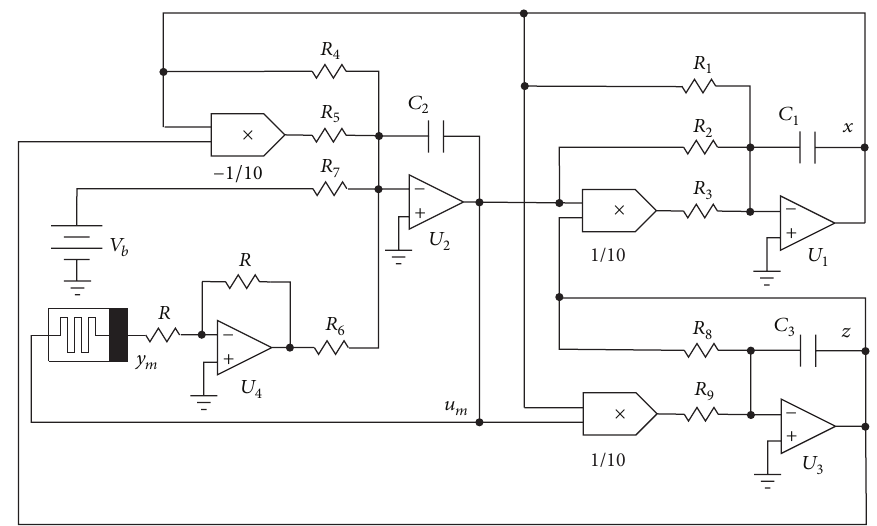
Figure 6: Circuital schematic of the new hyperchaotic system without equilibrium (5) based on the memristive device (2).